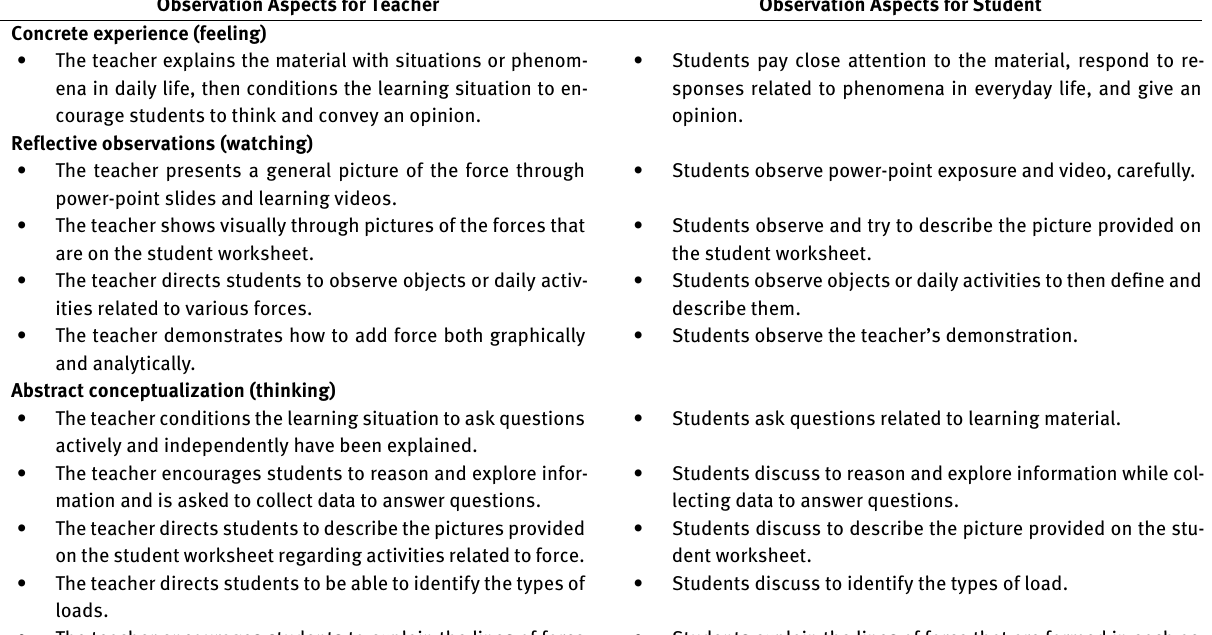
Observation Aspects for Teacher